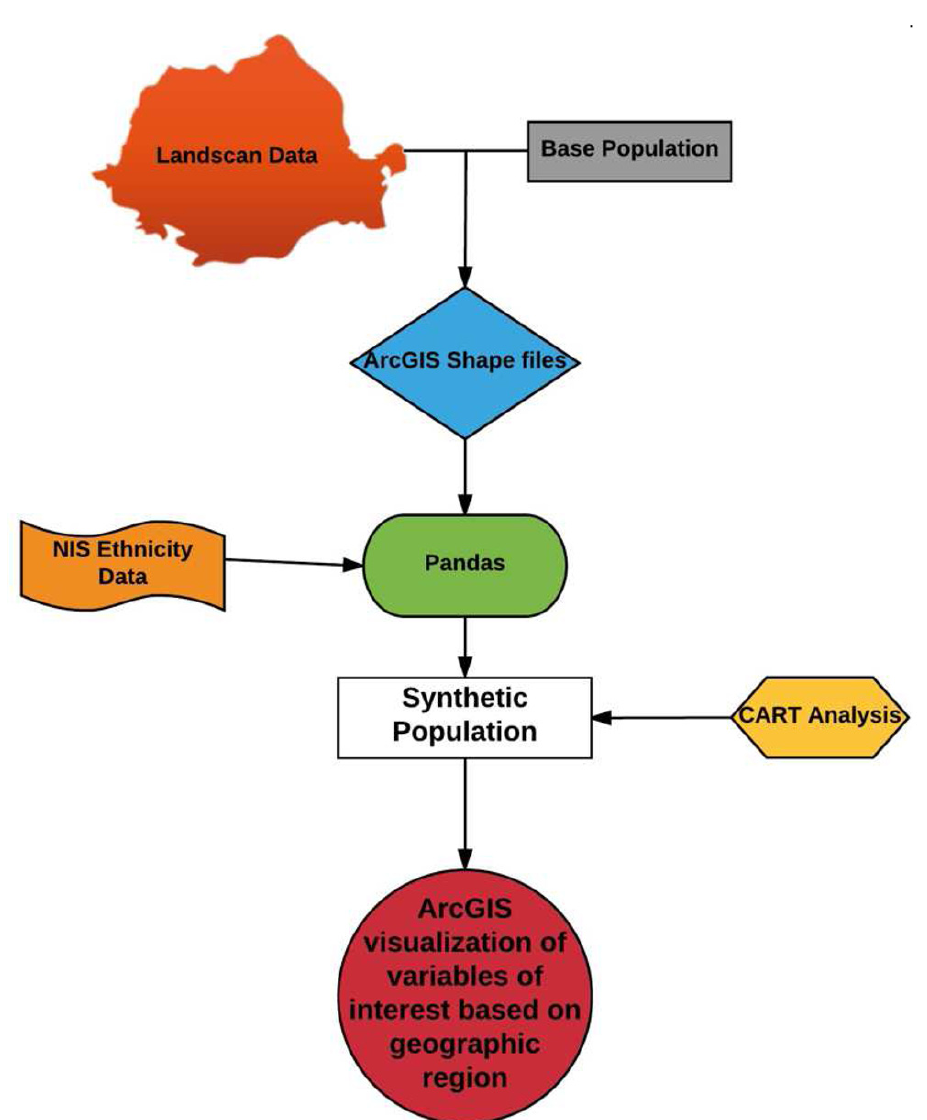
Figure 1. Work Flow to Generate Synthetic Population and ArcGIS